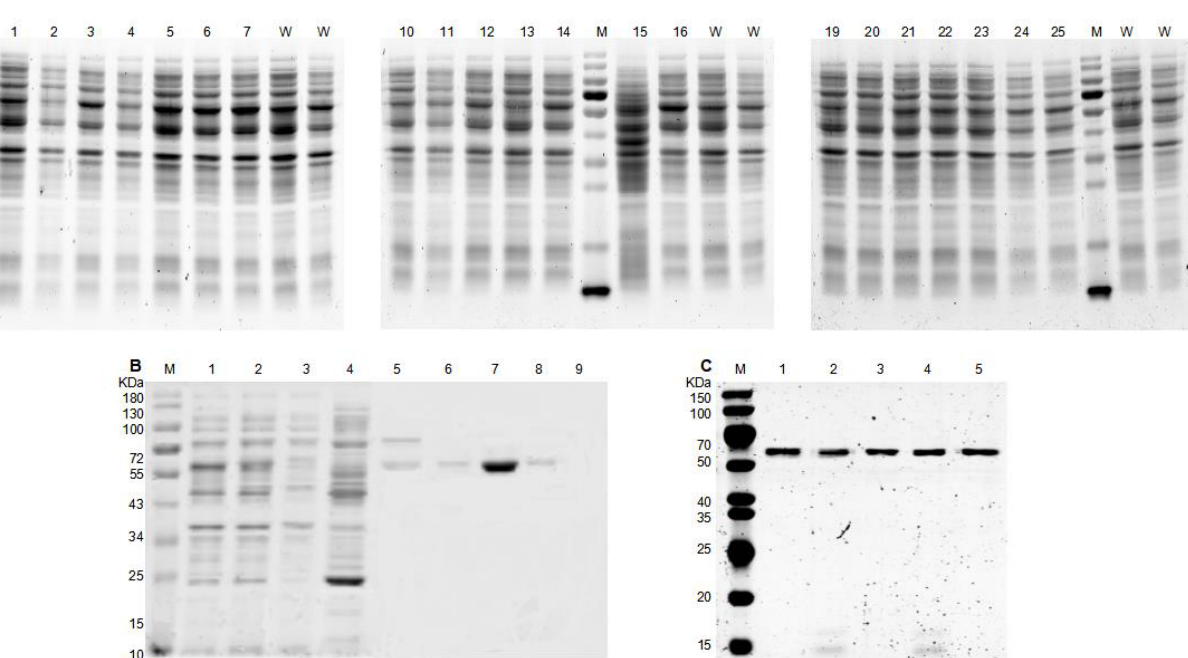
Figure 3. The xylose and ethanol tolerance of the variants from the first-round screening. The orange and blue spots indicate the relative activity of variants in the presence of 0.9 M xylose and 20% ( v/v ) ethanol, respectively. The wild type was used as the control and labeled with the black dashed line.